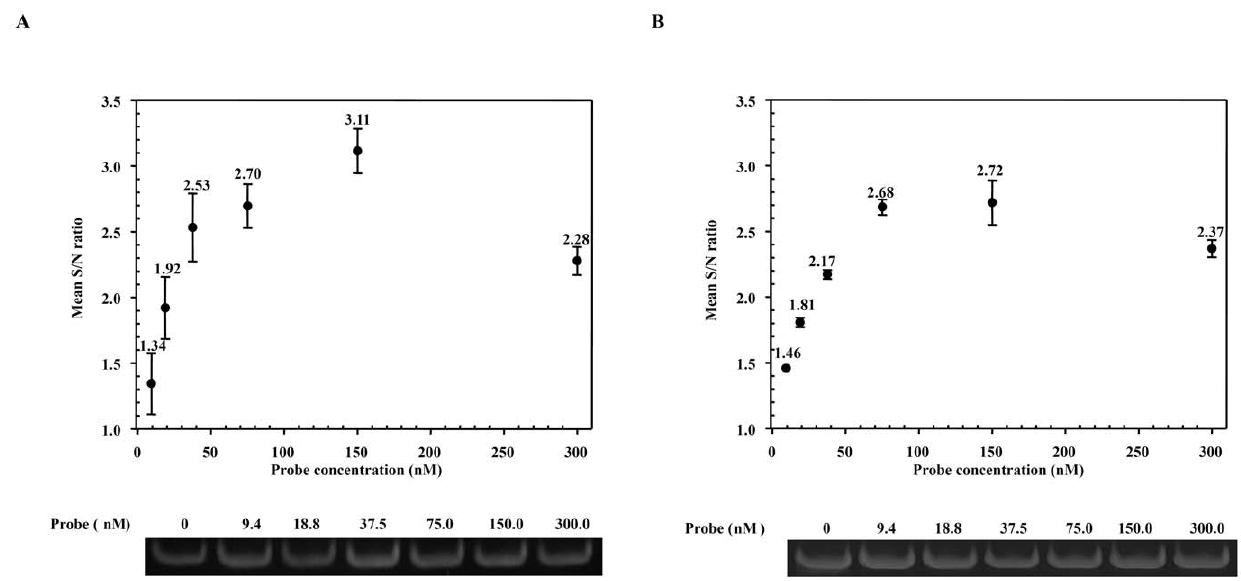
Figure 3. Effects of concentration of TaqMan probe on production of fluorescent signals. Different concentrations (9.4, 18.8, 37.5, 75, 150, or 300 nM) of WSSV probe or IMNV probe were added to the WSSV (A) or IMNV (B) iiPCR, respectively. Each reaction was performed in triplicate. Mean S/N ratio of each reaction (shown on each mark) was plotted against probe concentration. Mean S/N ratios for reactions containing no probe (not shown on the plot) were 0.97 (SD=0.08) and 0.94 (SD=0.01) for WSSV and IMNV assays, respectively. Bottom panel shows an example of gel electrophoresis analysis. S/N ratio, fluorescent intensity after /fluorescent intensity before . Amplicons were analyzed on a 12% polyacrylamide gel in 1X TAE buffer. M, DNA size markers.